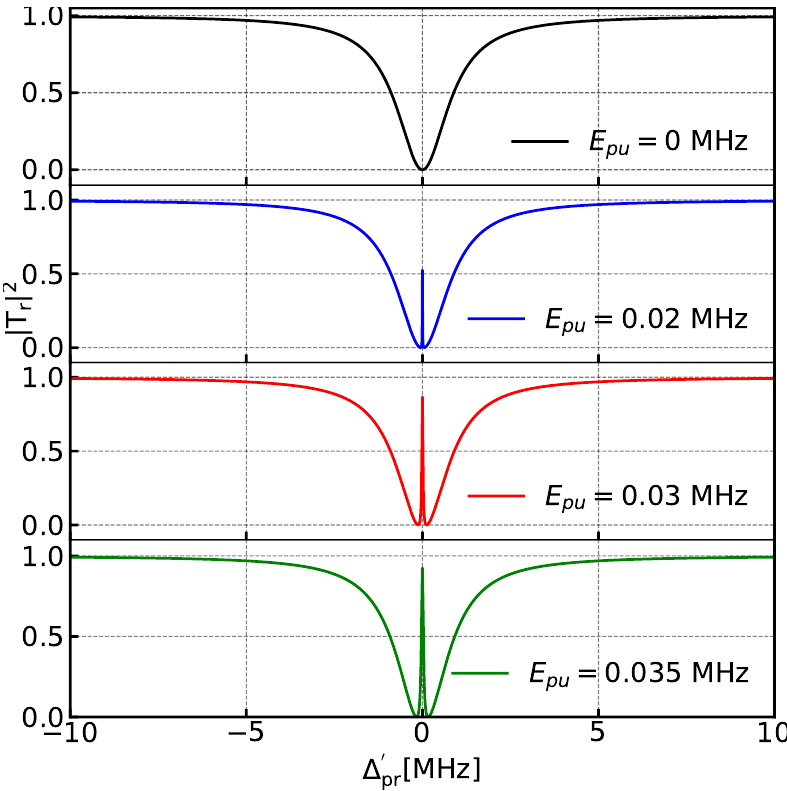
Figure 2. Plot of transmission coefficient | T r | 2 of the probe laser power as function of the effective probe-cavity detuning ∆ (cid:48) pr = ω pr − ω (cid:48) c when pump laser field E pu = 0 (black), 0.02 (blue), 0.03 (red) and 0.035 (green) MHz, respectively. Other parameters are U 0 = 2 π × 20 kHz, λ = 500 nm ( K (cid:39) 10 7 m − 1 ), L = 100 µ m, N (cid:39) 5000, k F (cid:39) 10 8 m − 1 , κ = 2 π × 1 MHz, M = 1.5 × 10 − 25 kg, and the Fermi frequency ω F ≡ (cid:101) F /¯ h (cid:39) 10 MHz, g 0 = 2 π × 10 MHz, and the pump-atom detuning ω pu − ω a = 2 π × 30